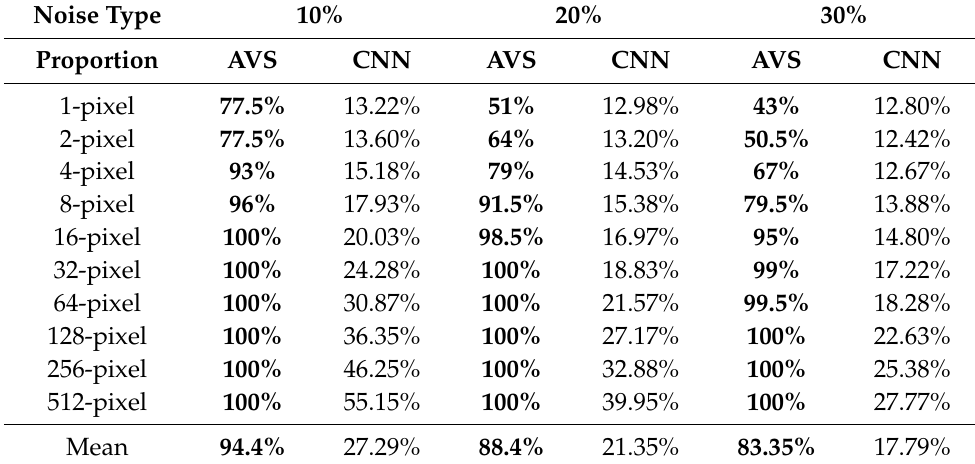
Table 5. The experimtental results of AVS and CNN under the static full-image